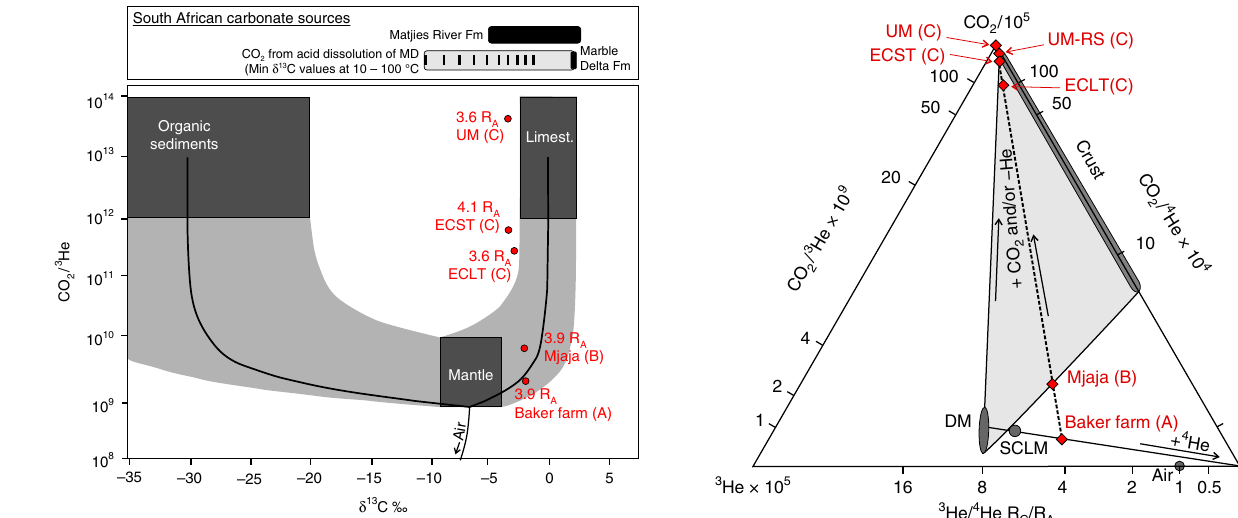
Fig. 3 Ternary plot of CO 2 / 3 He, CO 2 / 4 He and 3 He/ 4 He of Bongwan CO 2 samples. Relevant end-members, after 45 , with relative concentrations calculated for CO 2 , 3 He, and 4 He, based on these ratios. Scaling factors are introduced to the CO 2 and 3 He values, as labelled, to allow the full spread of data to be represented. The scaled relative concentrations are then normalised to a three-component system where CO 2 + 3 He + 4 He = 100%, permitting direct comparison of the relative proportions of CO 2 , 3 He, and 4 He, regardless of absolute concentrations. Binary mixtures and loss or gain of any single component will plot as straight lines. The plot shows that the Bongwan CO 2 samples have been in fl uenced by two separate processes: (1) Mixing between depleted upper mantle (DM) (8 ± 1 R A ) 46 or sub-continental lithospheric mantle (SCLM) (6.1 ± 0.9 R A ) 47 and a radiogenic 4 He component, and (2) Addition of a high-CO 2 , low- 3 He and 4 He component and/or loss of both 3 He and 4 He relative to CO 2 . The Baker Farm sample lies on the fi rst mixing line, and the addition of CO 2 free of 3 He and low in 4 He and the effect of shallow preferential degassing of He relative to CO 2 in the near-surface 48 can account for the second trend.